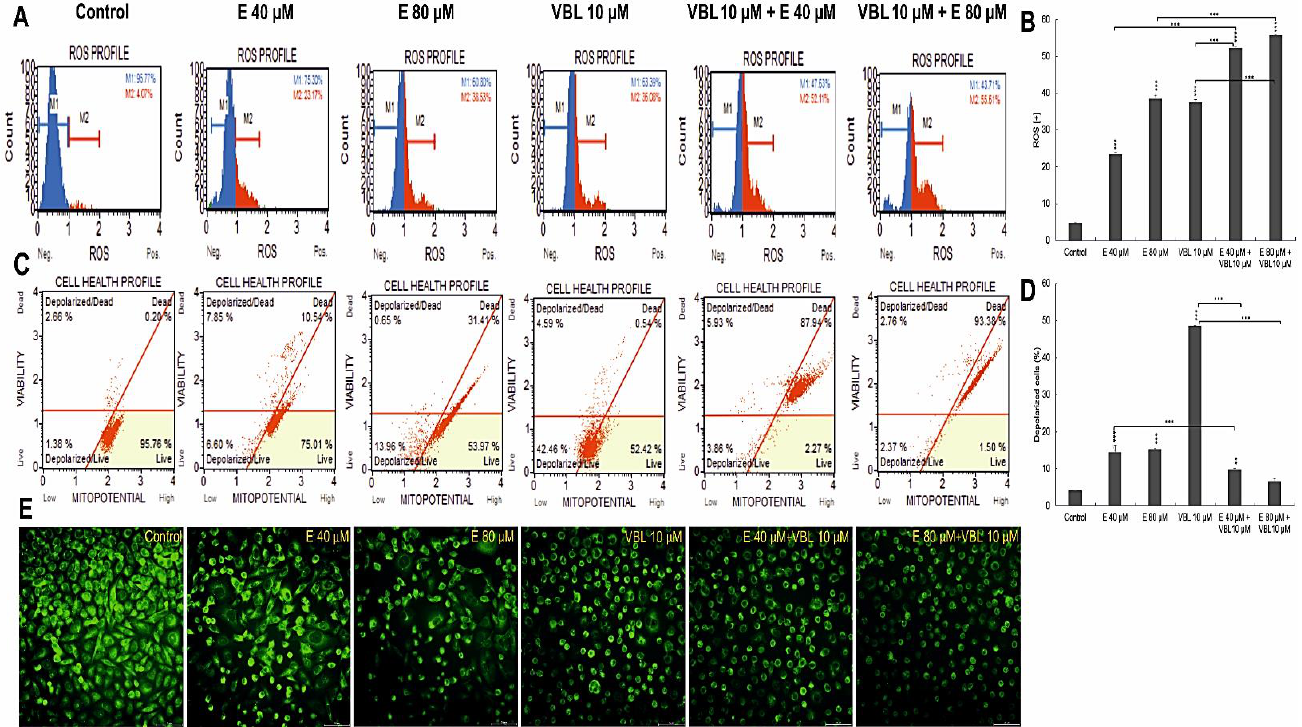
Figure 7. Assessment of ROS production and changes in mitochondrial potential in cells after treatment with vinblastine and emodin. ( A ) Generation of reactive oxygen species by 40 and 80 µM emodin, vinblastine (10 µM) and emodin in combination with vinblastine (E 40 µM + 10 µM VBL and E 80 µM+10 µM VBL). M1: negative cells, ROS (-); M2: cells with ROS activity, ROS (+). ( B ) Percentage of ROS (+) cells induced by test compounds. The degree of ROS production in HeLa cells was determined in comparison with the control. ( C ) Changes in mitochondrial membrane potential depending on the concentration of vinblastine and emodin. ( D ) Percentage of cells with mitochondrial membrane depolarization. Each sample was analyzed in triplicate. The differences were statistically confirmed at: ** p < 0.01, *** p < 0.001. ( E ) Analysis of changes in mitochondrial activity (rhodamine 123 staining). Visible control cells with high mitochondrial membrane potential and cells with reduced emission of fluorescent dye after the incubation with emodin, vinblastine and after combined action of compounds. Magnification × 400.